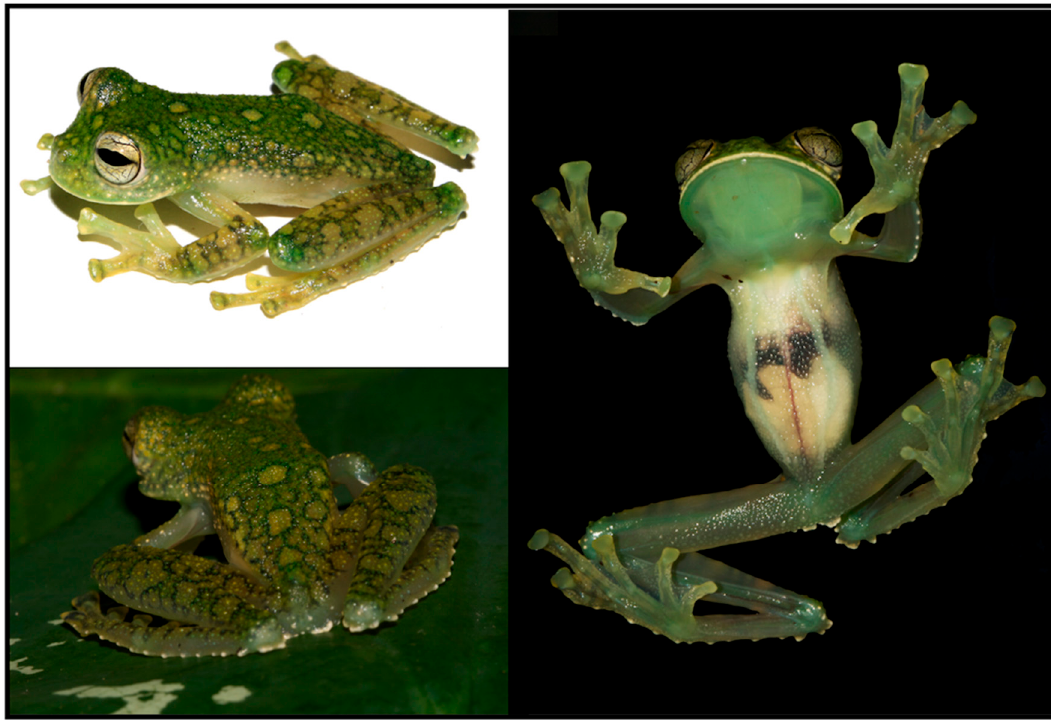
Figure 30. Centrolene charapita in life. Type series from near La Olivia, 682 m, Departamento Amazonas, Peru. Photos by Santiago Castroviejo-Fisher and Evan Twomey. Peru. Photos by Santiago Castroviejo-Fisher and Evan